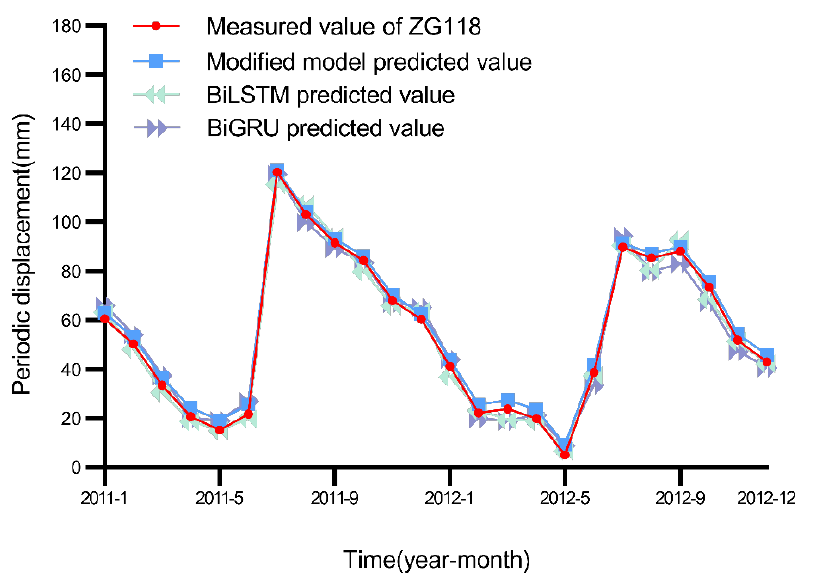
Figure 22. Periodic displacement predicted results of ZG118 using LSTM-FC, BiLSTM and BiGRU models.